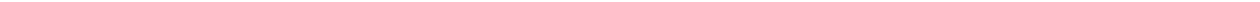
Fig. 4 In vivo NO generation and anti-cancer effect of PMT system. a Schematic illustration of the NO responsive element contained sensing plasmid and its in vitro NO responsiveness ( n = 3). b In vivo NO generation of PMT system in 4T1 Nrf2-luc tumor-bearing mice. The imaging was performed 24 h after the i.v. injection of E. coli , CCN@ E. coli (10 8 CFU mL − 1 in 200 μ L saline), and CCN (5 mg mL − 1 in 200 μ L saline). c MRI images for detecting both in